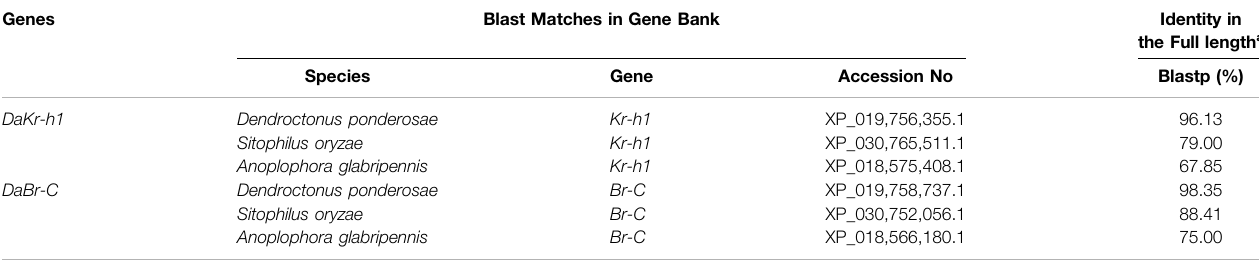
TABLE 1 | Amino acid identity of putative DaKr-h1 and DaBr-C with related sequences in other insect species. Genes Blast Matches in Gene Bank